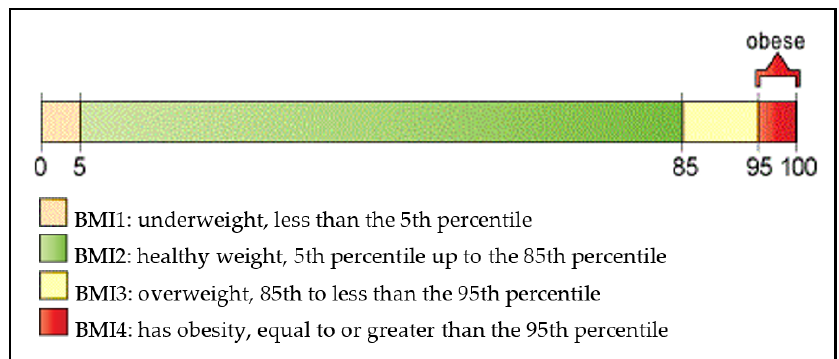
Figure 1. CDC BMI Percentile Calculator for Child and Teen [31].